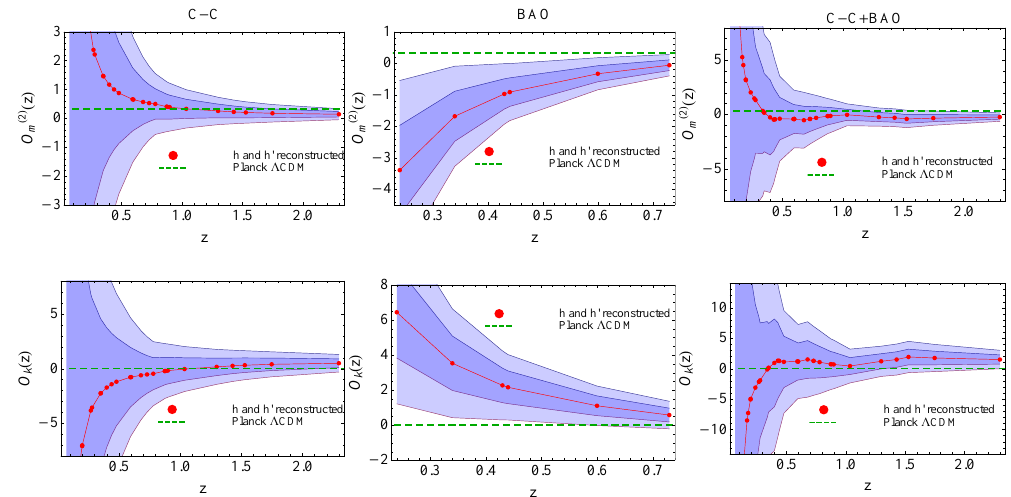
( 2 ) Figure 4. Reconstruction of the O m and O k diagnostics for C-C data ( left column), BAO data ( middle column) and C-C+BAO data ( right column). The red dots (line) are (is) the reconstructed O values using the reconstructed h and h (cid:48) via Loess–Simex. The dashed green line is Ω m = 0.315. Shaded purple areas represent the 68% and 95% confidence regions. Top row: O h and h (cid:48) reconstructed via Loess–Simex; Bottom row: O k diagnostic with h and h (cid:48) reconstructed via